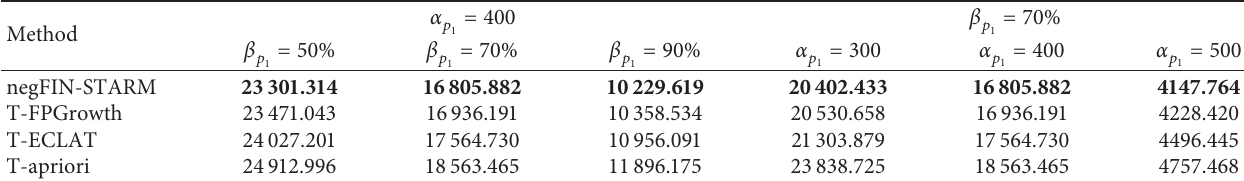
� 400. (b) Q � p � 70%. 􏼈 􏼉 and α 􏼈 􏼉 and β p 1 p 1 1 1 􏼈 􏼉 . 1